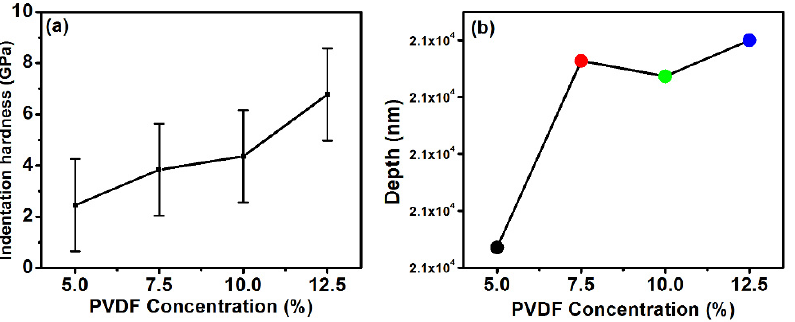
Figure 3. Mechanical characteristic of synthesized electrode at different PVDF concentrations: ( a ) Indentation hardness ( b ) depth penetration.